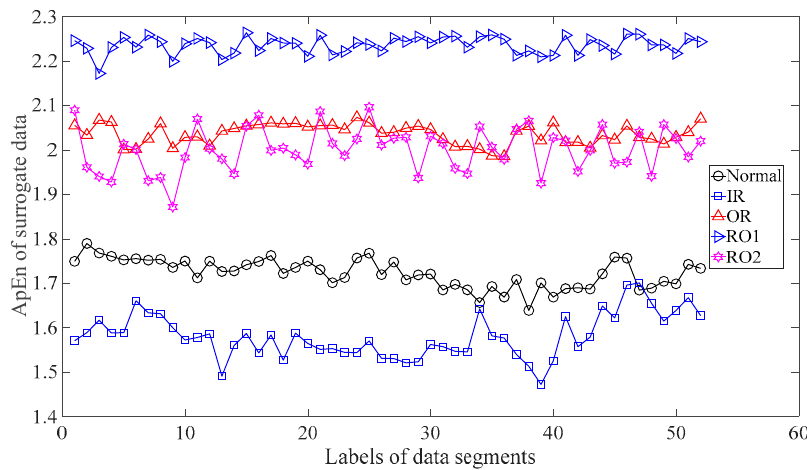
Figure 19. ApEn of the surrogate versions of the five types of roller-bearing vibration data.